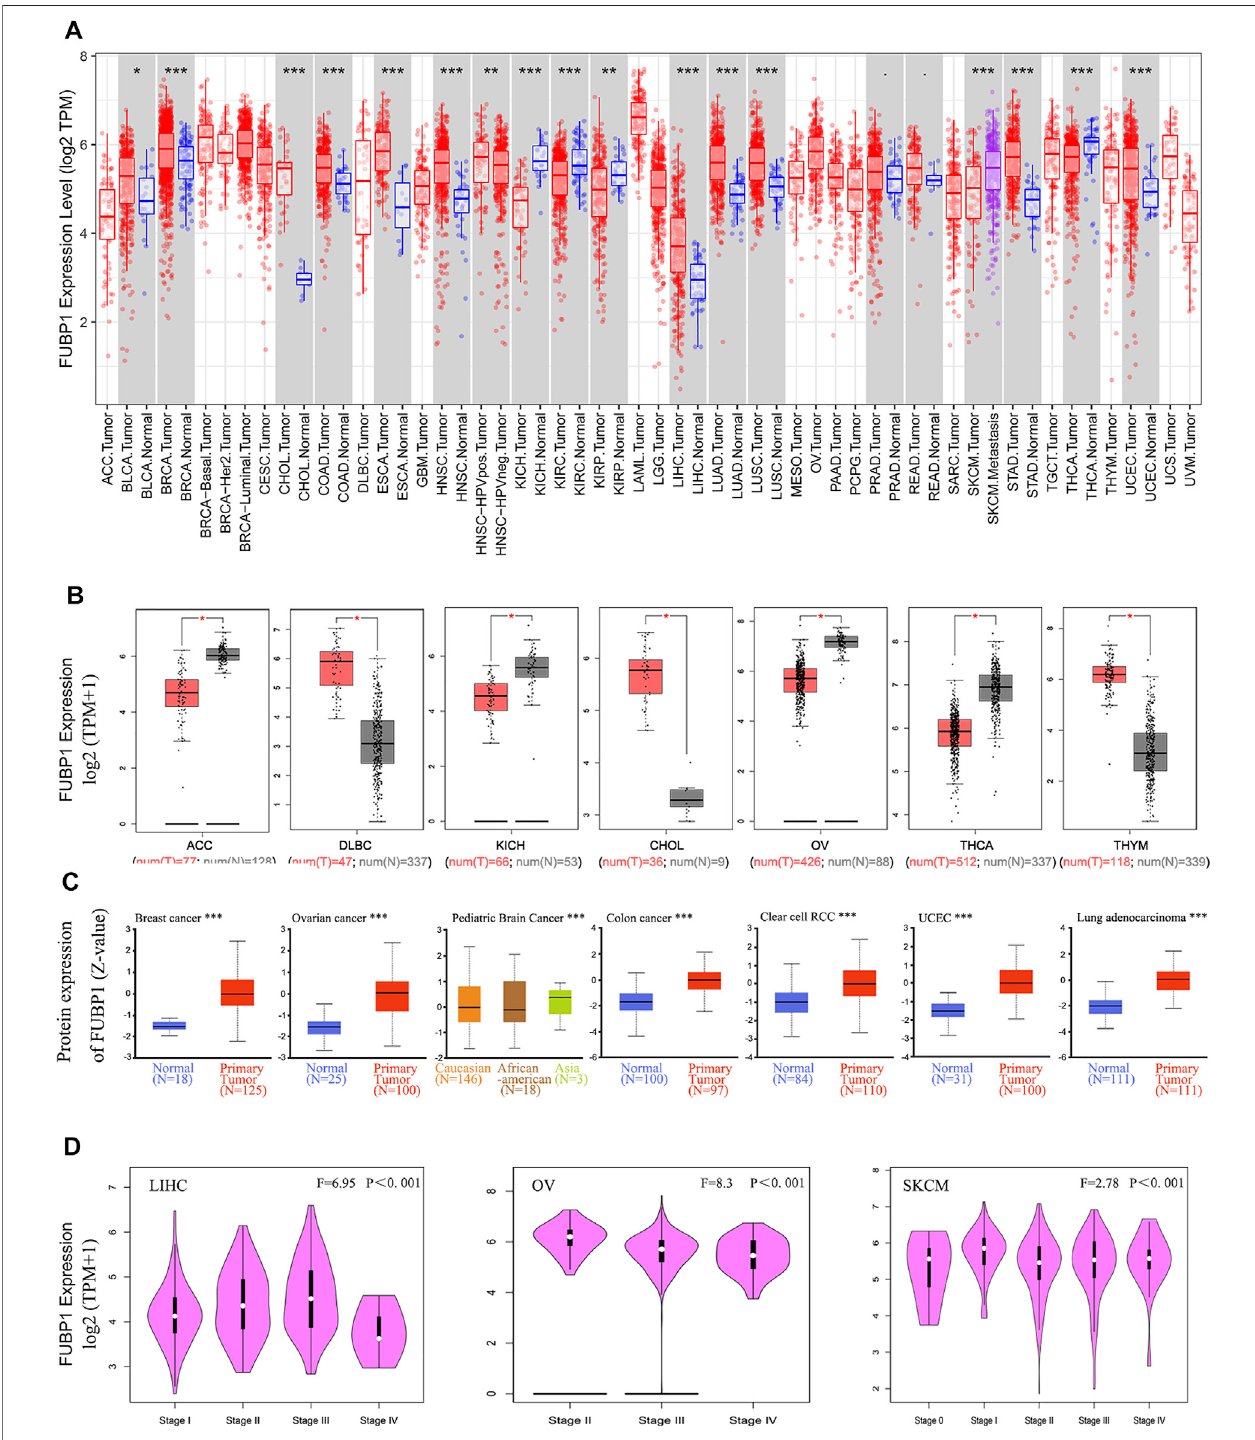
FIGURE1| ExpressionofFUBP1accordingtocancertypeandclinicalpathologicalstageinTCGAdatasets. (A) Thespeci fi cexpressionlevelof FUBP1 indifferent cancer types and corresponding normal tissues in TCGA database was analyzed using TIMER2. (B) GTEx datasets were used to analyze the expression of FUBP1 in ACC, DLBC, KICH, CHOL, OV, THCA, and THYM. Log 2 (TPM+1) was applied to represent the expression level. (C) The total protein expression level of FUBP1 was analyzed between the primary tumor and the corresponding normal tissues with the CPTAC data. (D) The expression of FUBP1 in different clinical stages of LIHC, OV, and SKCM was quanti fi ed with log 2 (TPM+1) and visualized by GEPIA2. * p < 0.05, ** p < 0.01, *** p < 0.001.